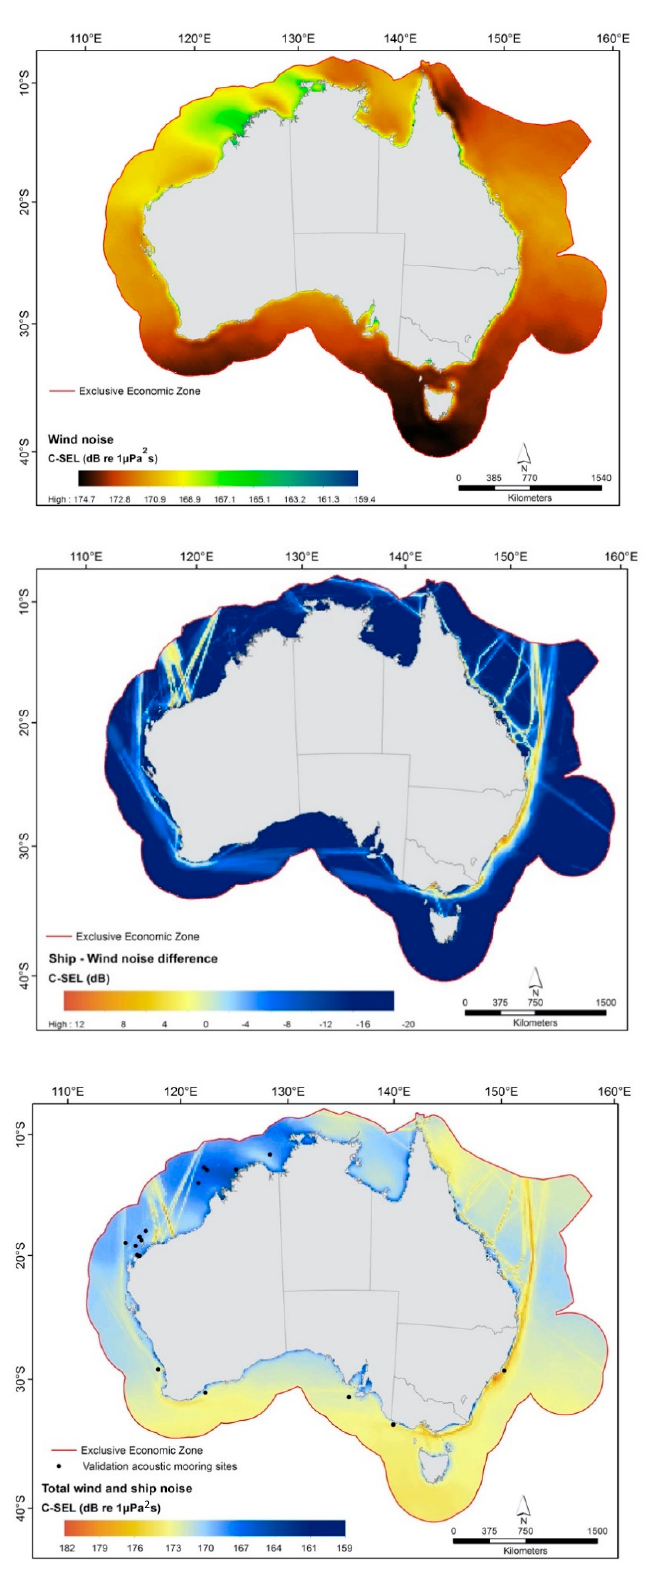
Figure 7. Maps of modelled wind noise within Australia’s EEZ during winter 2012 (1 April–30 September: top ), ship C-SEL less wind C-SEL ( middle ), and C-SEL from ships and wind combined ( bottom ). The black dots identify underwater recording stations used for validation. To convert to mean sound pressure level, subtract 72 dB re 1 s.